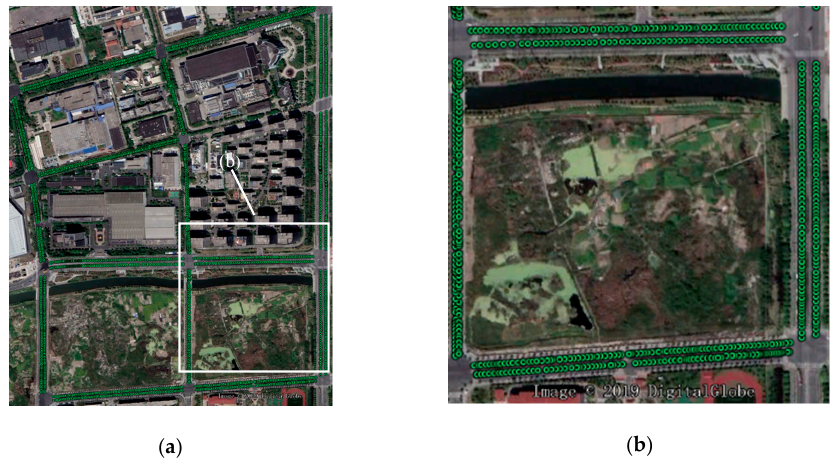
Figure 8. Experimental area and raw data: ( a ) Road segment centerline points; ( b ) enlarged road segment centerline raw trajectories.